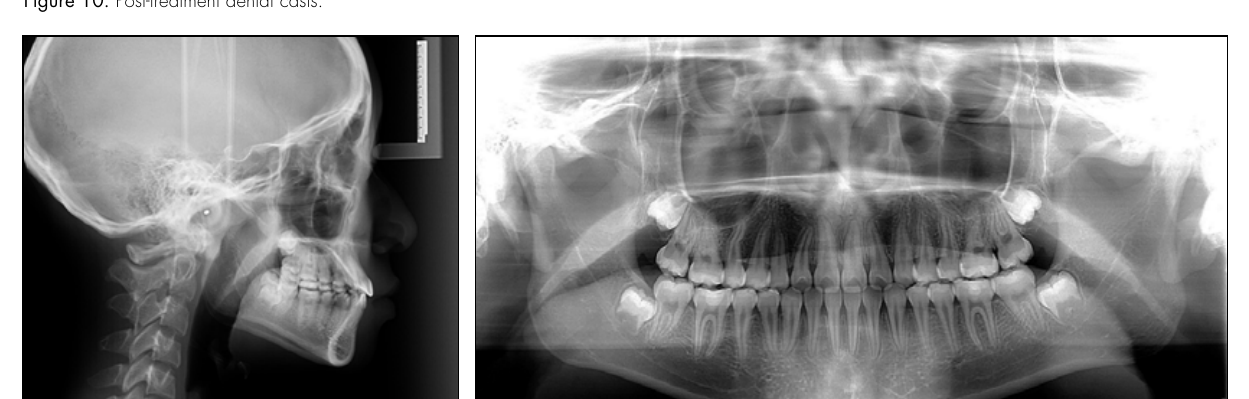
Figure 11. Post-treatment